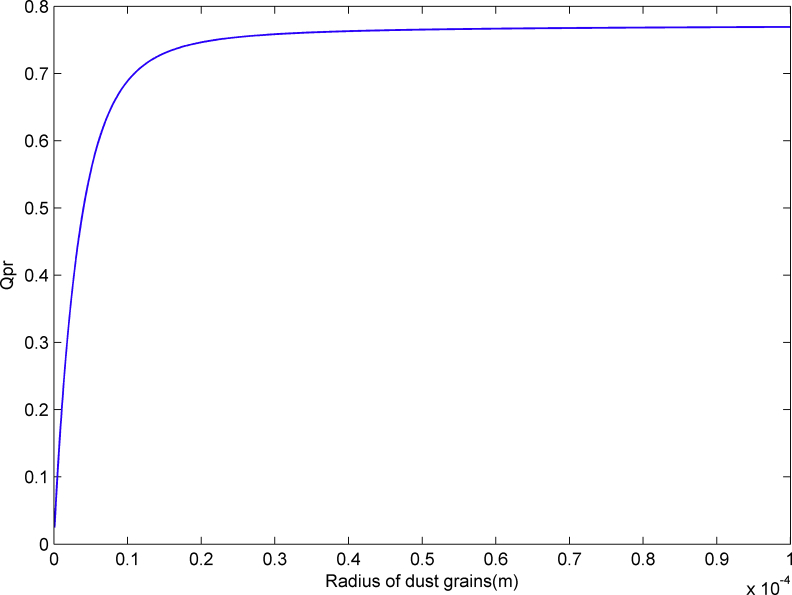
The value for Qpr.